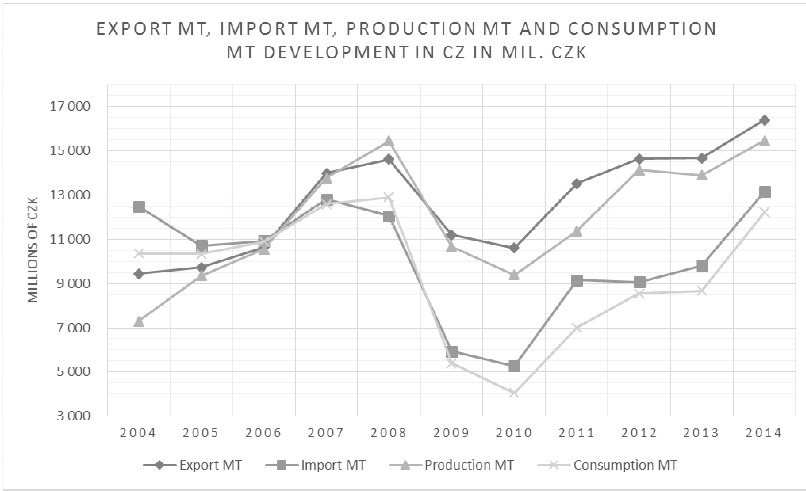
Fig. 4 - The development of indicators in Machine Tools Branch in the Czech Republic from 2004 to 2014 in million CZK constant prices. Source: Association of Engineering Technology: Reports on the state of Machine Tools Branch in the Czech Republic